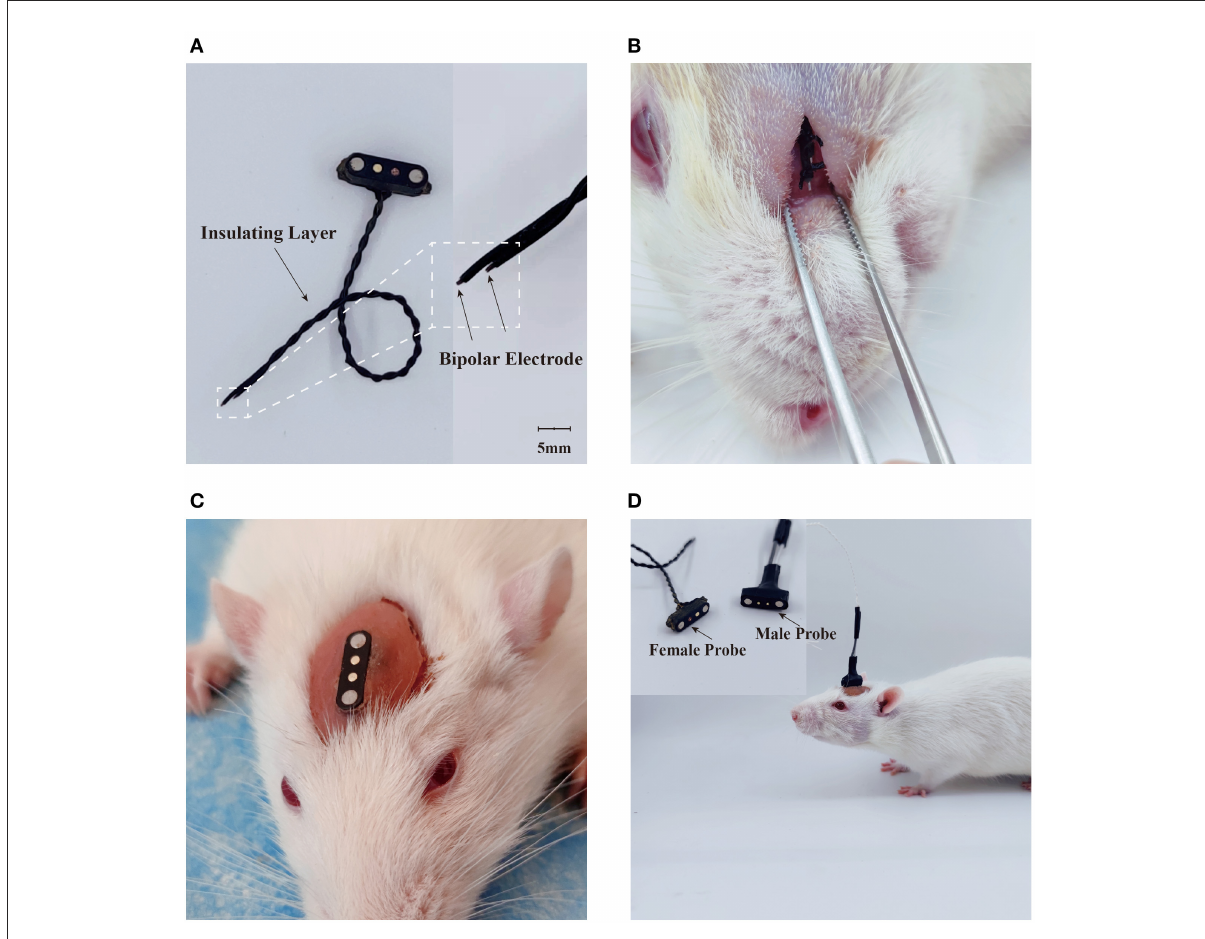
FIGURE2 Design of electrical stimulation device. (A) Construction of electrical stimulator. (B) Placement of stimulation tetrode. (C) Implantation of electrical stimulation device. (D) Delivery of electrical stimuli in the freely-moving